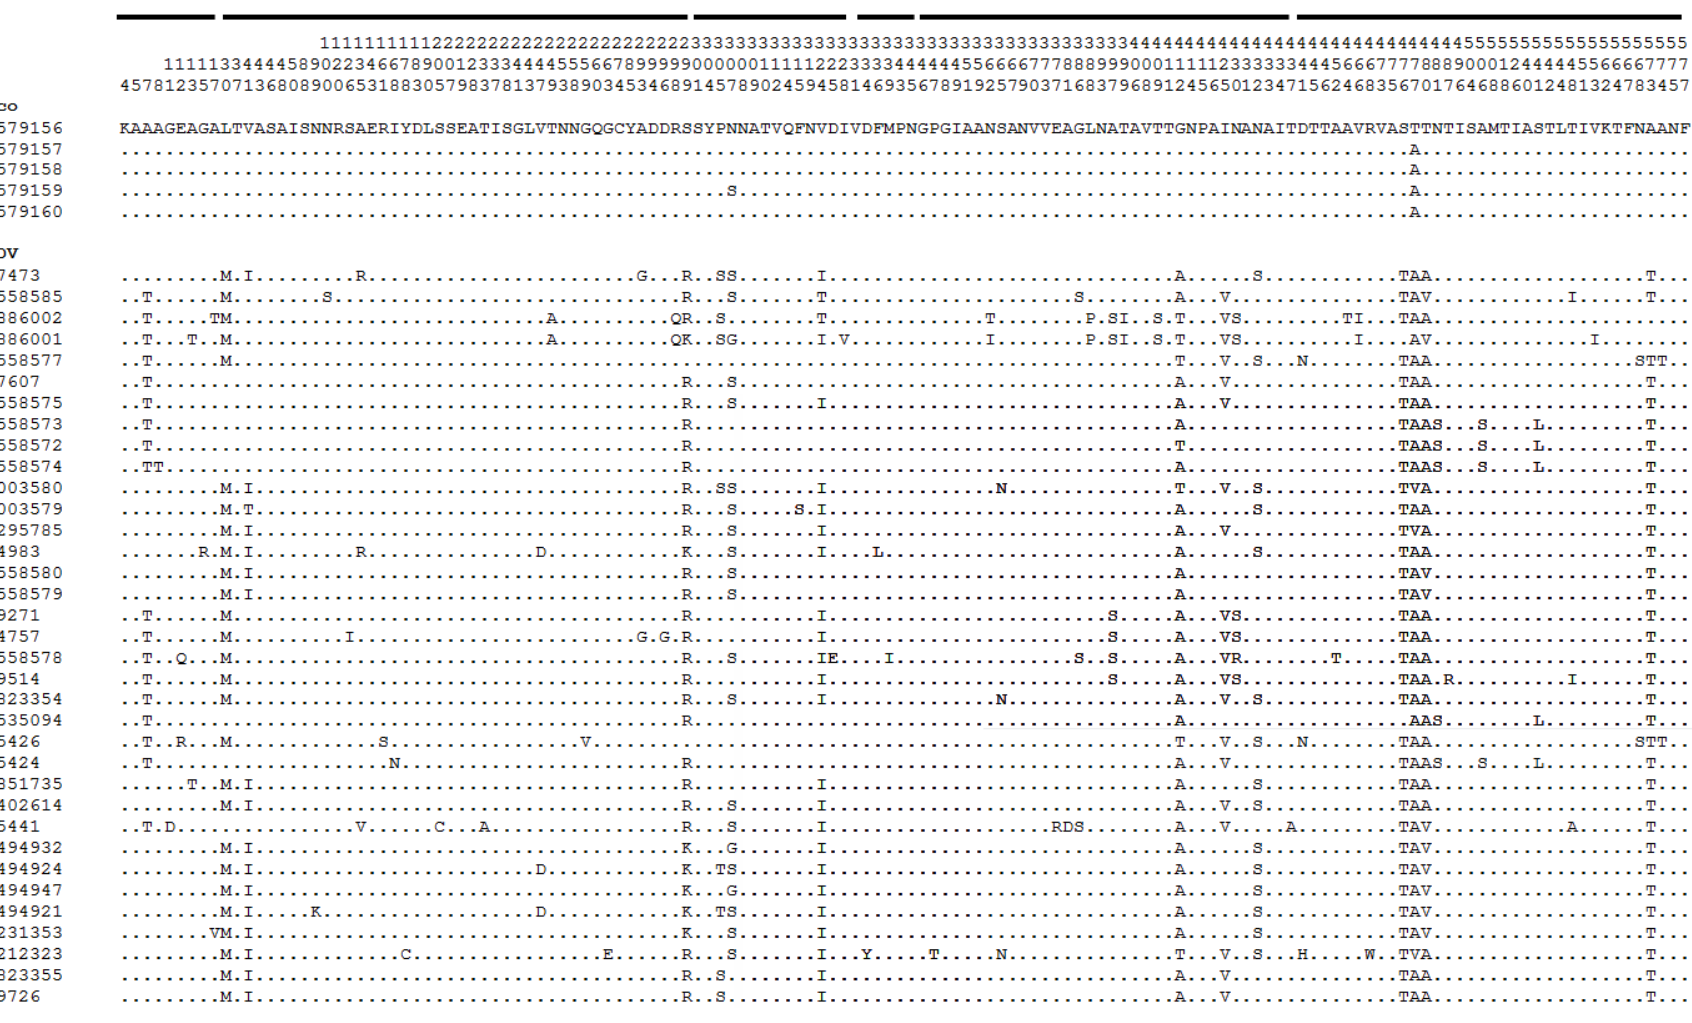
Figure 2. Amino acid polymorphic positions in the RHDV VP60 capsid. The different capsid regions are indicated at the top [29]. Dots represent the identity with the sequence Pico13-05 (GenBank Accession number